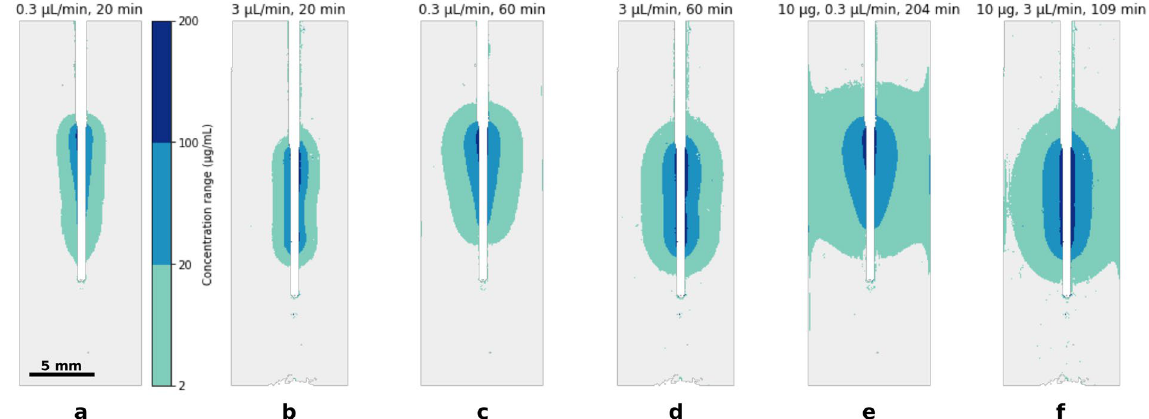
Figure 8. Concentration maps for flow rates of 0.3 μL/min and 3 μL/min; ( a ) and ( b ) After 20 min; ( c ) and ( d ) After 60 min; ( e ) and ( f ) For the same delivered mass of 10